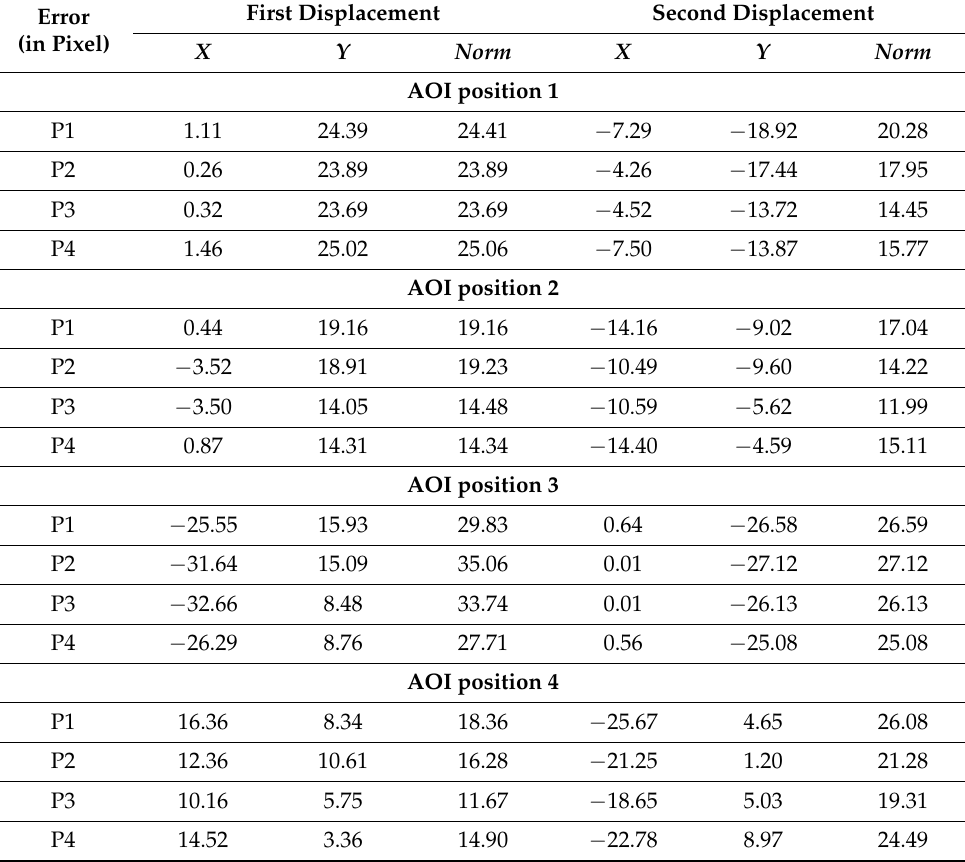
Table 4. Error analysis of the object position correction system (measured in